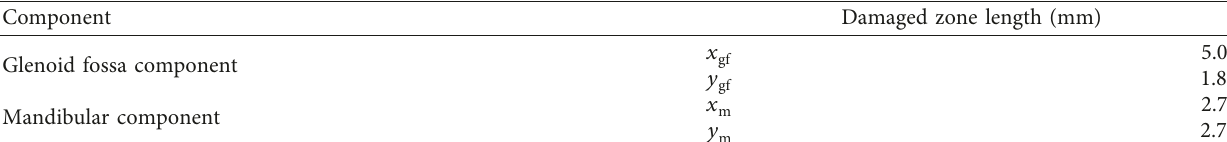
Table 5: Average longitudinal and traverse dimensions of the damaged zone within the contact interface of a resected after failure Christensen TMJ prosthesis specimen by